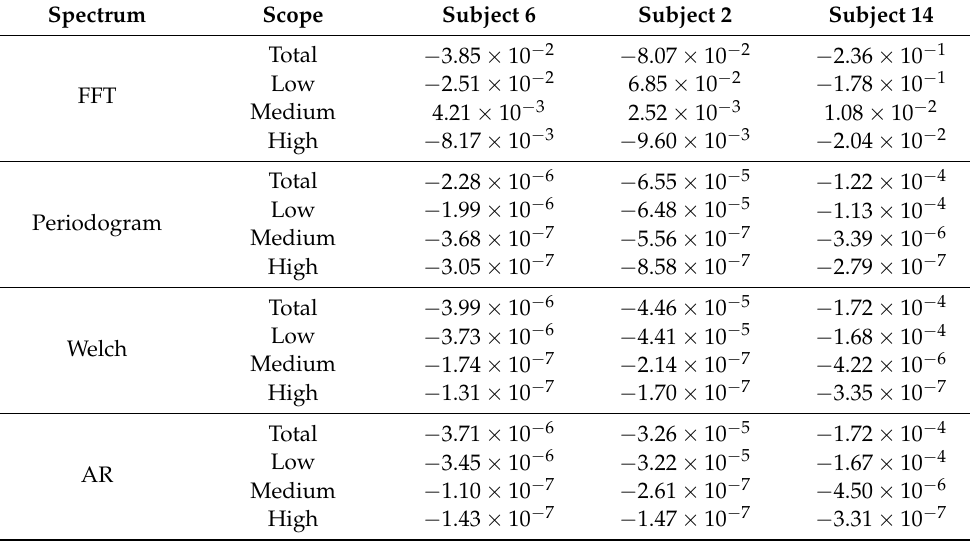
Figure 11. Power graphs of signal spectra for three chosen subjects. ( a ) FFT; ( b ) Periodogram; ( c ) Welch; ( d ) AR. Table 2. Spectral powers for three different subjects (left knee, microphone on the